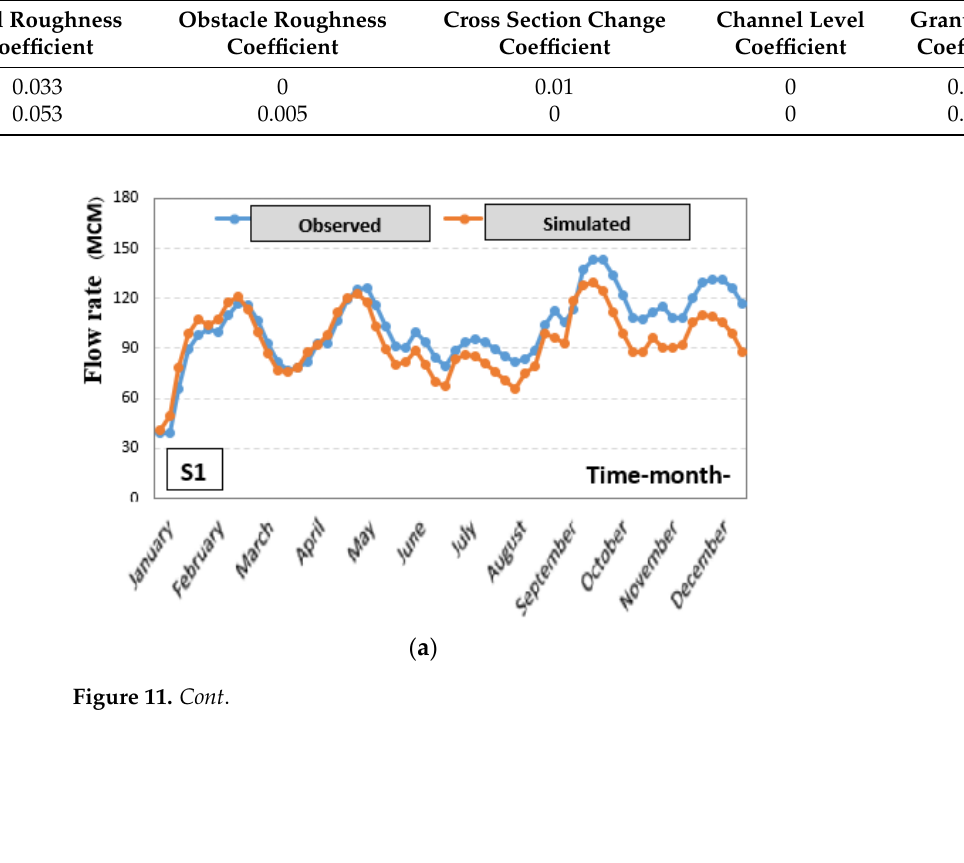
( b ) ( c ) Figure 11. Parameter Q for the QUAL2KW model during calibration for stations ( a ) S1; ( b ) S2; and ( c ) S3. 5. Conclusions and Recommendations Concerning the end of the Jarahi River in particular, for most of the warm months of the year, the concentration of DO was relatively reduced compared to the intersection with the Maroon River, but in most of the cold months of the year, this trend was reversed. The reason for this change in approach is the severe fluctuations in the river flow in hot and cold months of the year, especially the difference in discharge in the dry years with low rainfall and the wet years with high rainfall.